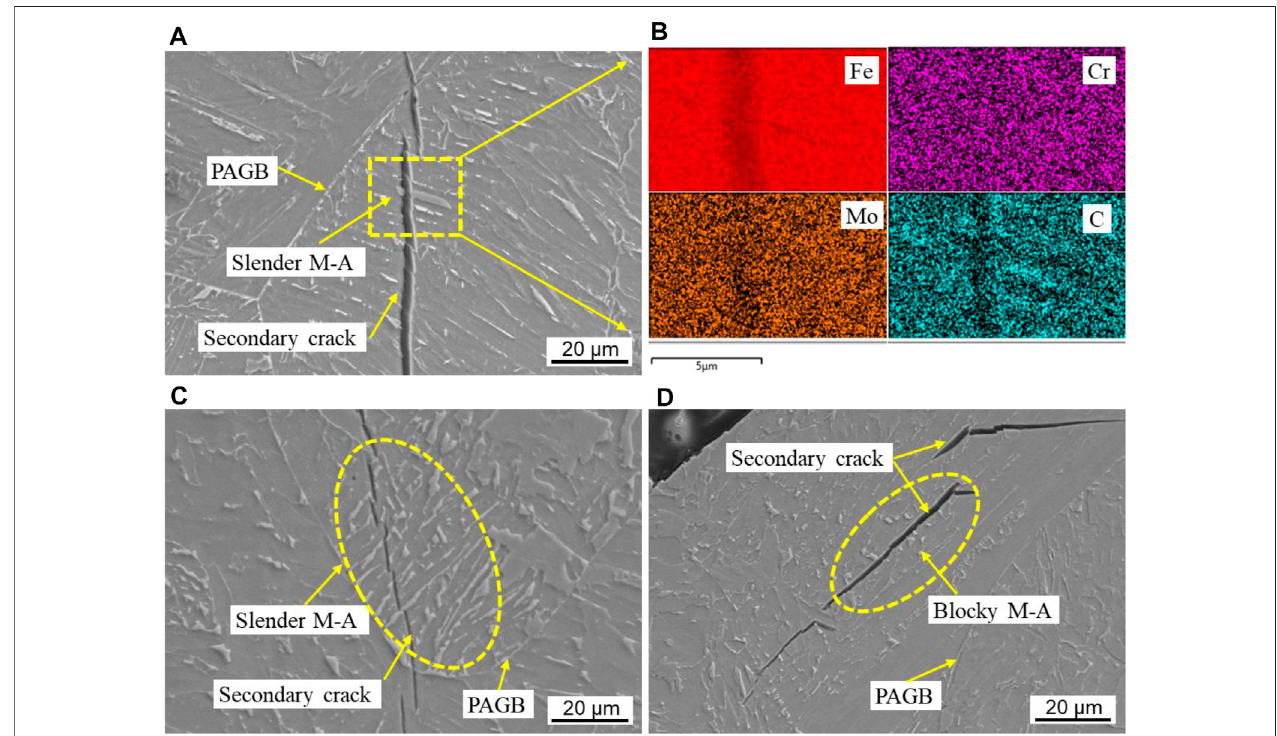
FIGURE 12 | SEM images of the secondary crack through the M – A cluster at the heat inputs of (A) 100, (C) 150, and (D) 200 kJ/cm and the corresponding EDS mapping (B) for (A ).